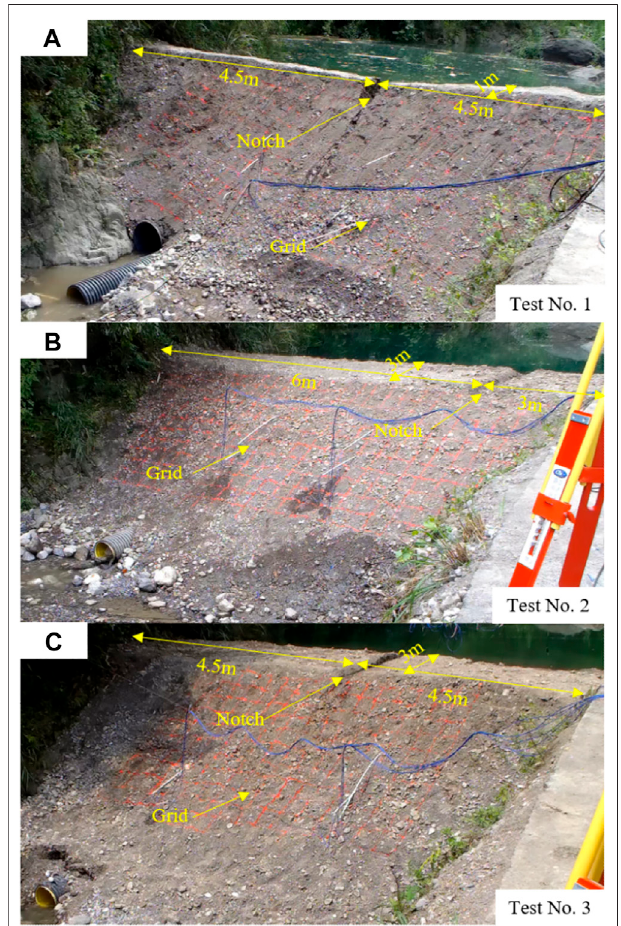
FIGURE 3 | Images of test dams after construction: (A) the dam of Test No. 1, (B) the dam of Test No. 2, (C) the dam of Test No.